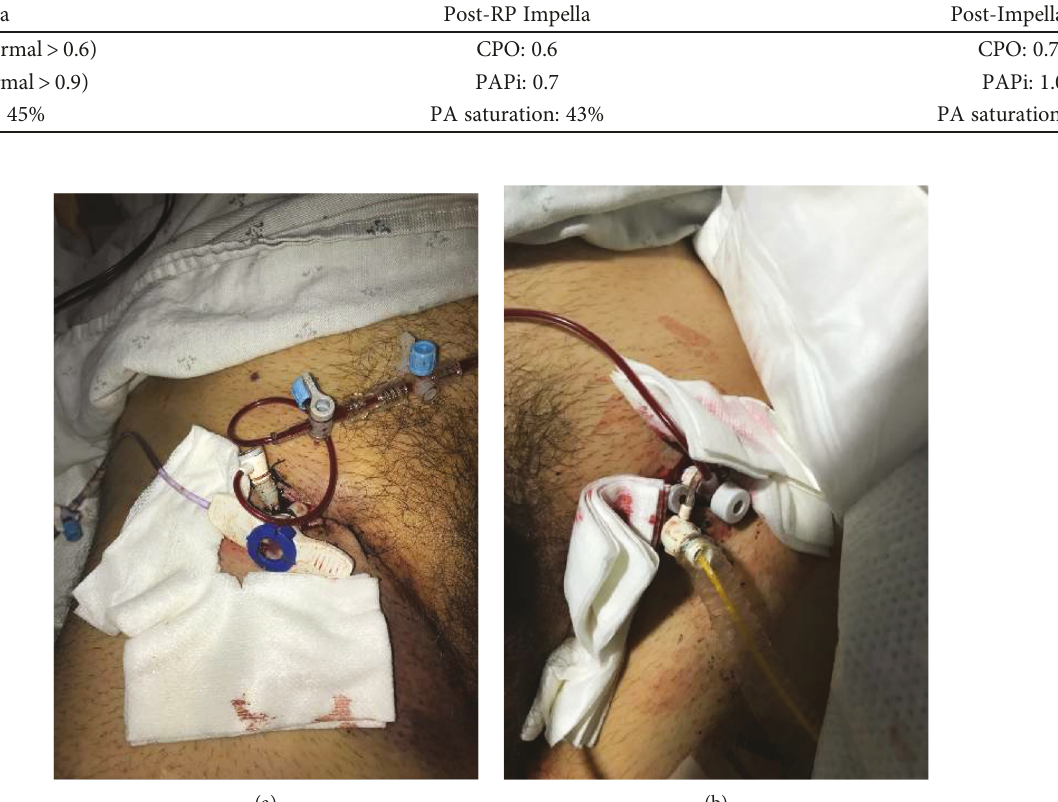
Figure 2: (a) Receiving limb of the external left femoral artery to right super fi cial femoral artery bypass. (b) Donor limb of the external left femoral artery to right super fi cial femoral artery bypass.